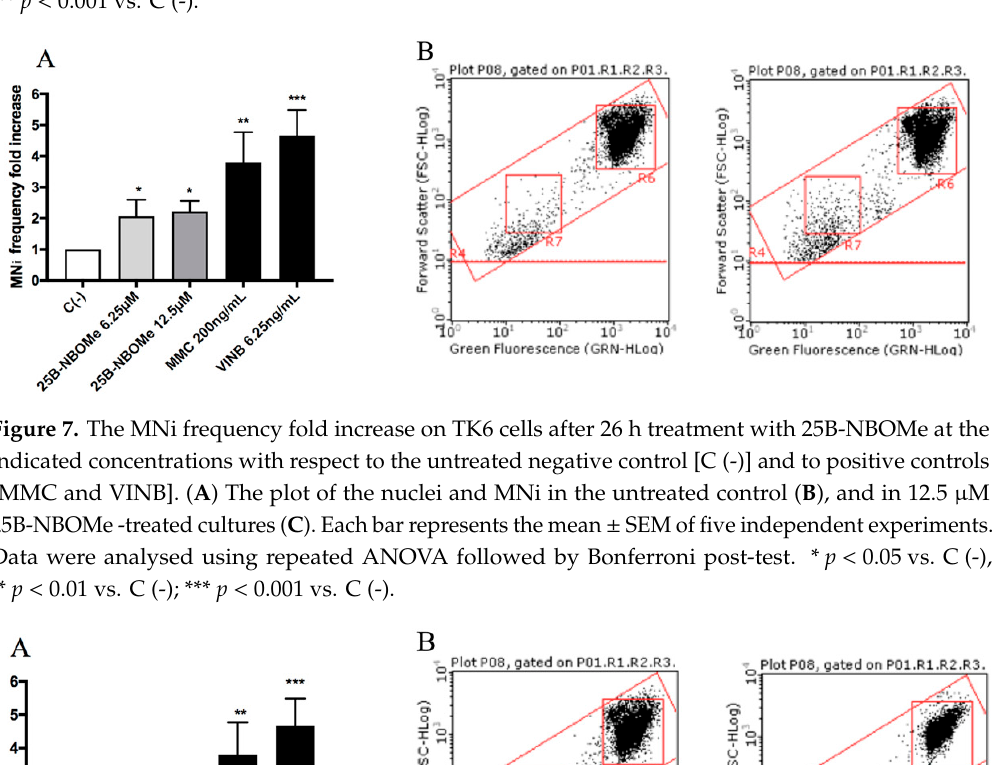
Figure 6. The MNi frequency fold increase on the TK6 cells after 26 h treatment with 2C-B at the indicated concentrations with respect to the untreated negative control C (-) and to positive controls [MMC and VINB]. ( A ) A plot of the nuclei and MNi in the untreated control ( B , left), and in 12.5 µM 2C-B-treated cultures ( B , right). Each bar represents the mean ± SEM of five independent experiments. Data were analysed using repeated ANOVA followed by the Bonferroni post-test. ** p < 0.01 vs C (-); *** p < 0.001 vs C (-).